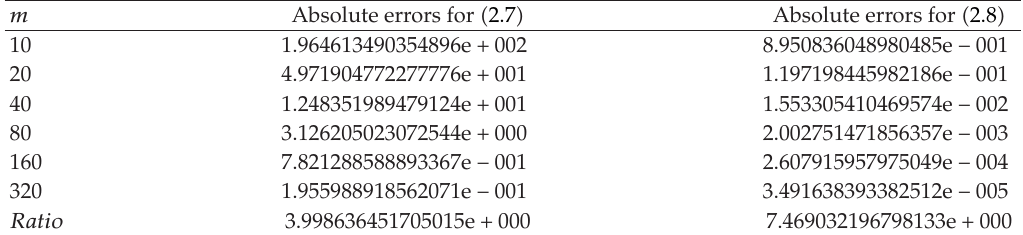
Table 4: Equation (cid:6) 5.1 (cid:7) in case of mid-point rule for (cid:6) 2.7 (cid:7) and (cid:6) 2.8 (cid:7) .